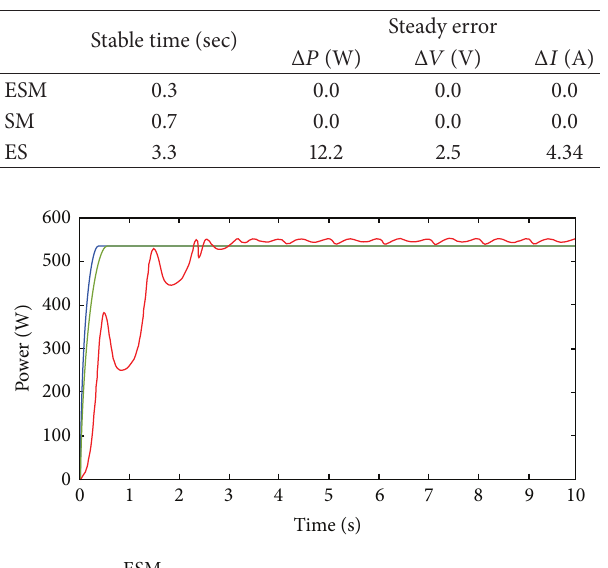
Table 2: Comparison of different control methods.